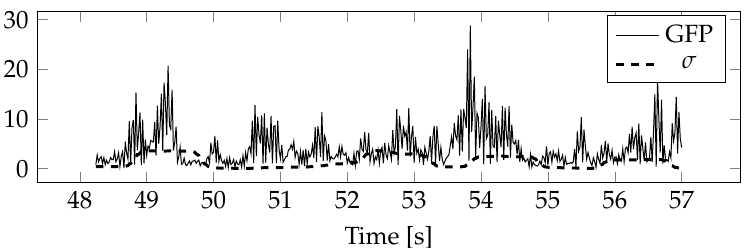
Figure 7. GFP for the alpha band calculated for the electrodes on the right side of the head and its approximate values of the upper limit of standard deviations.